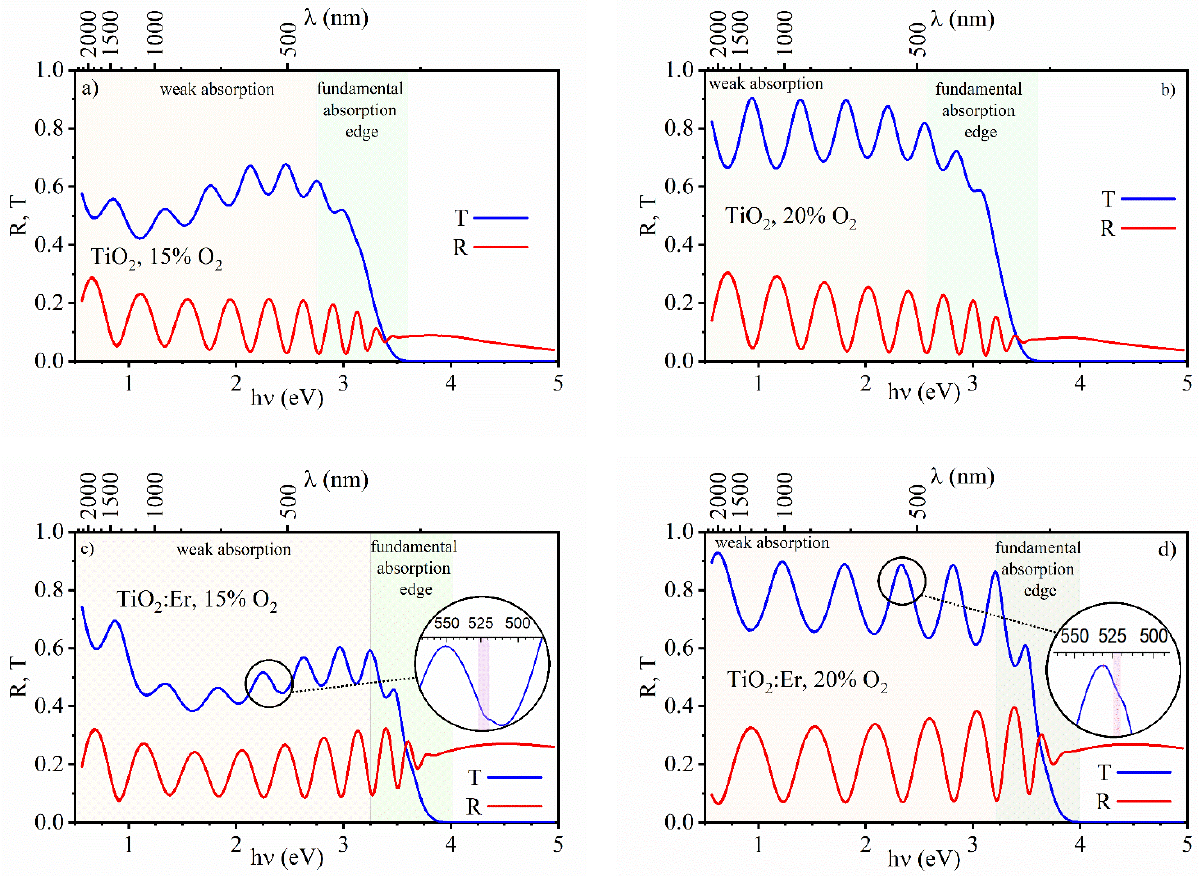
Figure 7. Spectral dependence of the transmittance T and reflectance R coefficients of thin films: undoped TiO 2 ( a ) 15% O 2 and ( b ) 20% O 2 ; TiO 2 :Er ( c ) 15% O 2 and ( d ) 20% O 2 . Additional absorption features zoomed-in circles.